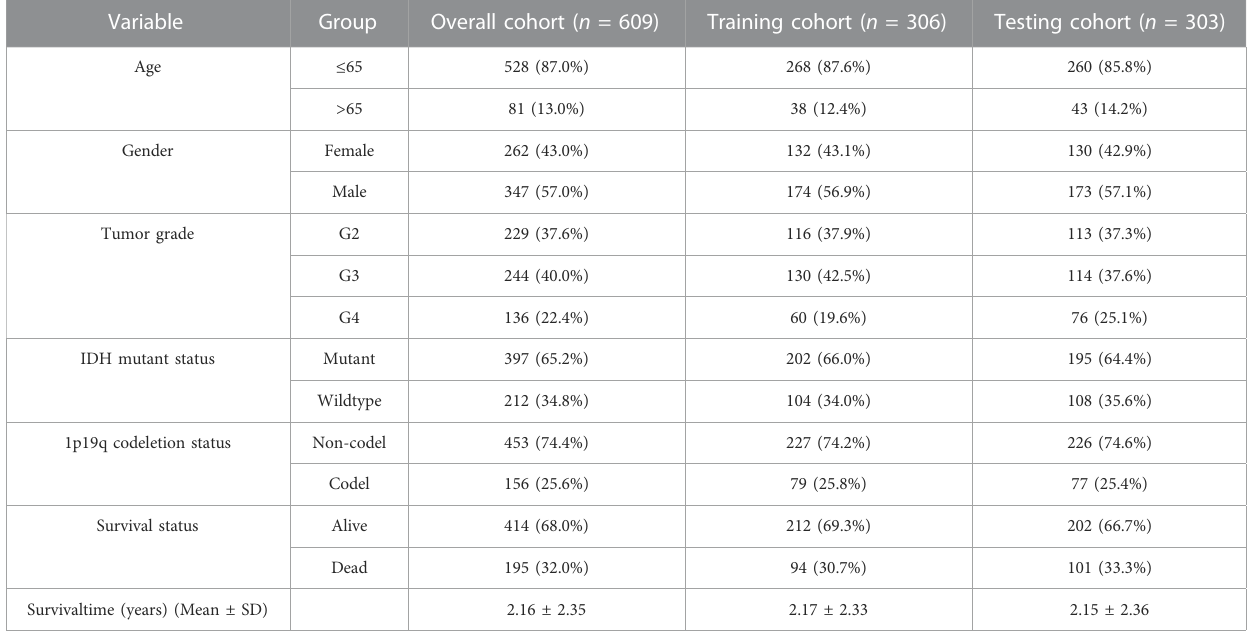
TABLE 1 The characteristics of glioma patients from TCGA in this